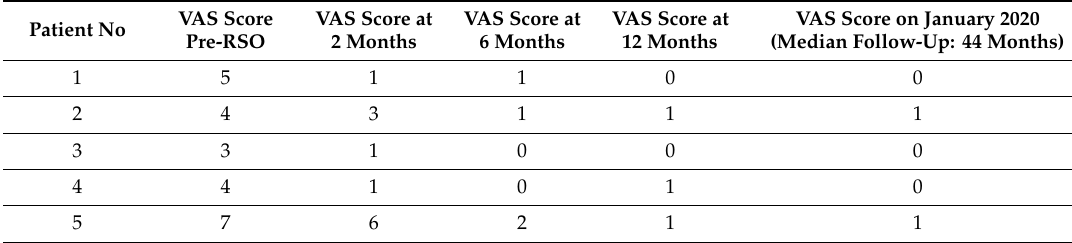
Table 3. VAS score before and after treatment of the studied